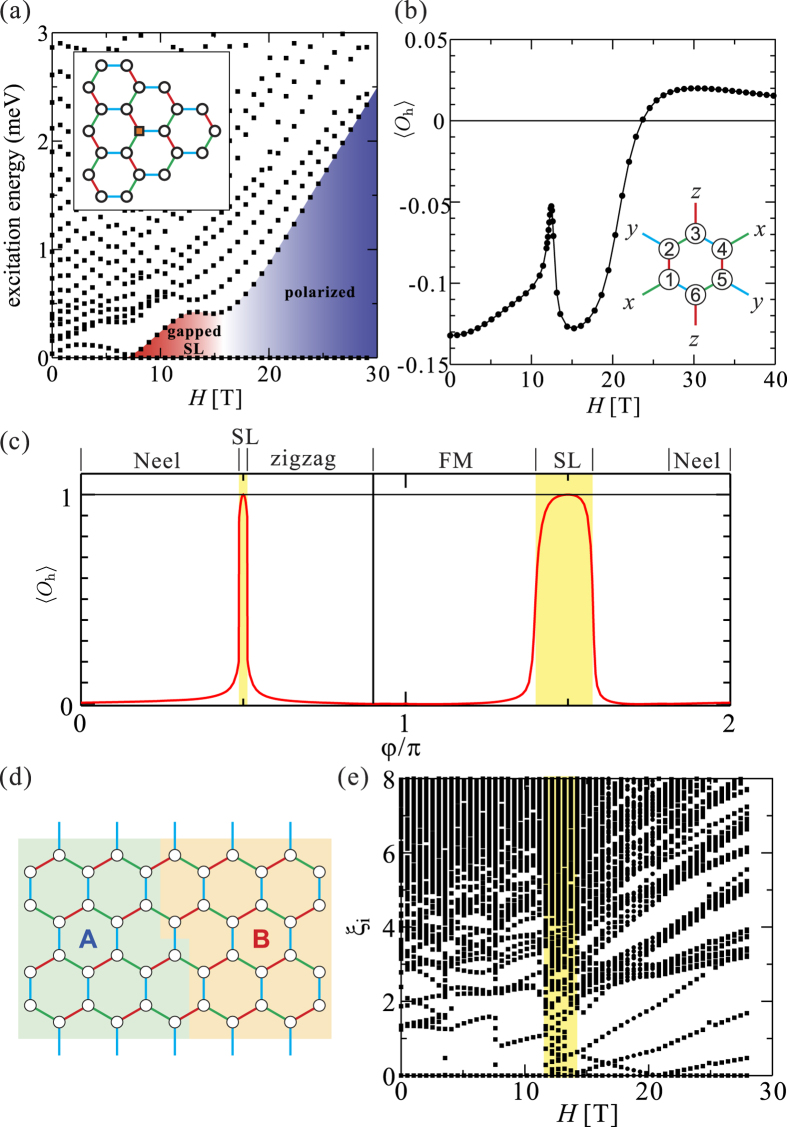
Excitation spectrum, plaquette operator and entanglement spectrum for α-RuCl3.(a) Energy spectrum Eν − E0 as a function of H (‖[001]) using the MRCI g factors and NN couplings plus J2 = J3 = 0.25 meV. Inset: 22-site cluster with OBC’s used in the ED calculations; the square indicates a target site to apply the spin-flip operator. (b) Expectation value of Oh as a function of H (‖[001]). Inset: labeling for the (hexagonal) plaquette operator Oh. (c) 〈Oh〉 vs φ plot for the plain NN Kitaev-Heisenberg model. (d) 44-site cylindrical cluster used in the DMRG calculation of entanglement spectra, with PBC’s for the vertical direction. (e) Resulting entanglement spectrum (H ‖ [001]); the off-diagonal NN couplings are set to 0 in the DMRG computations, J2 = J3 = 0.25.